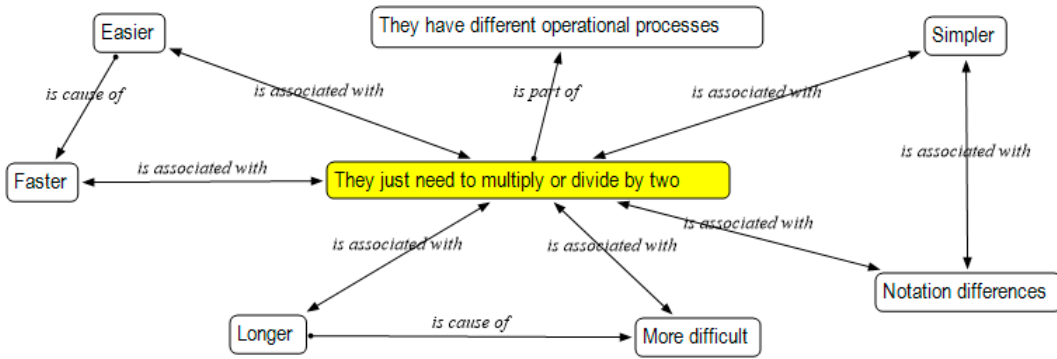
Figure 10. Relations of the It is only necessary to multiply or divide by two difference with the category of “mathematical processes”.